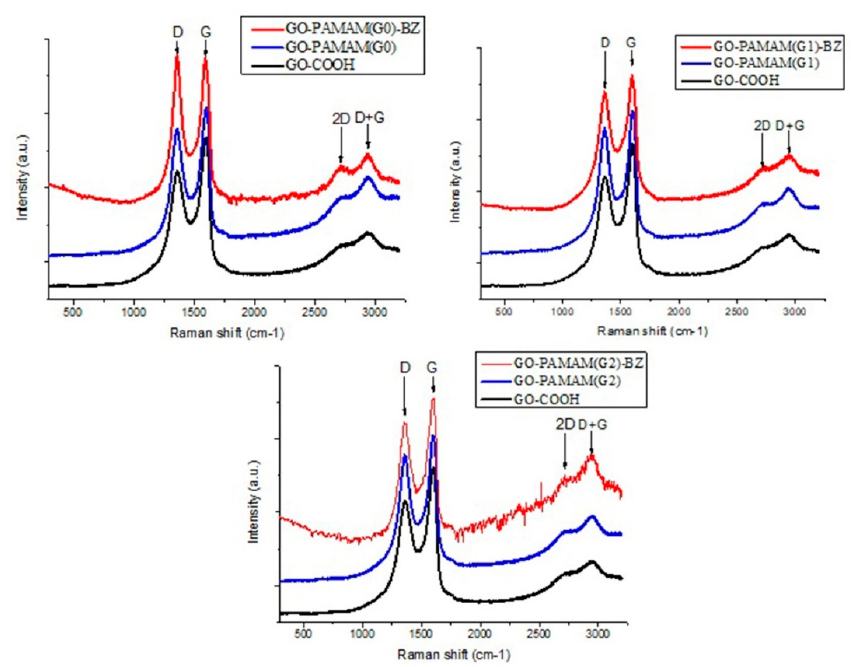
Figure 8. The Raman spectra of the raw material GO-COOH and hybrid monomers GO-PAMAM-BZ.